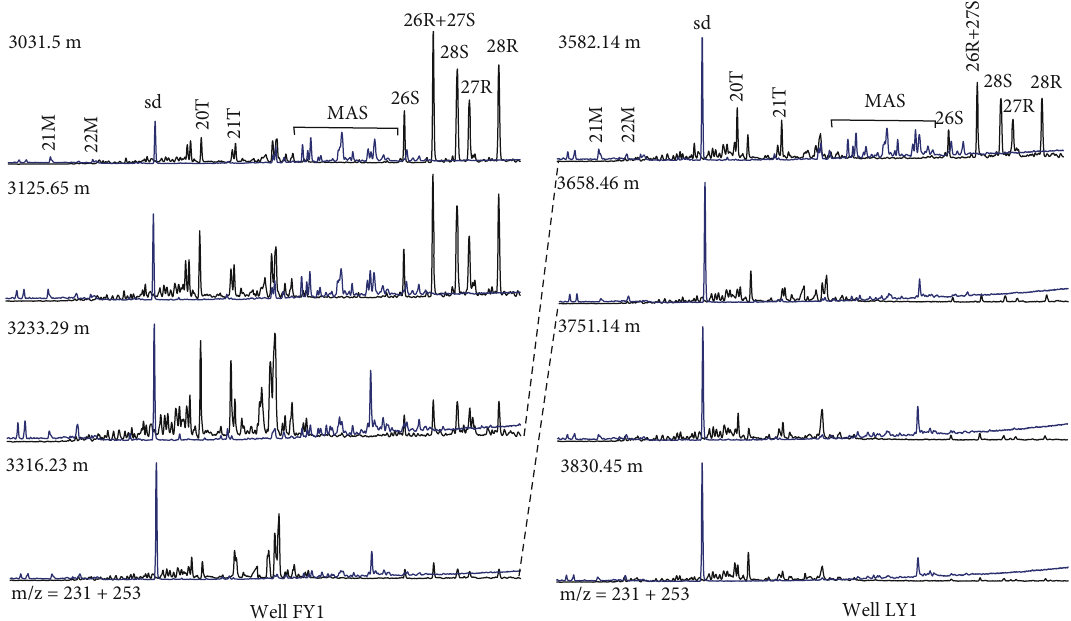
Figure 12: Mass chromatograms of m/z = 231 + 253 of the aromatic hydrocarbon fraction showing the typical distribution of mono- and triaromatic steroid hydrocarbons with increasing burial depth in wells FY1 and LY1. 21-22M: C C -C triaromatic steroids; 26-28R/S: C 20 21